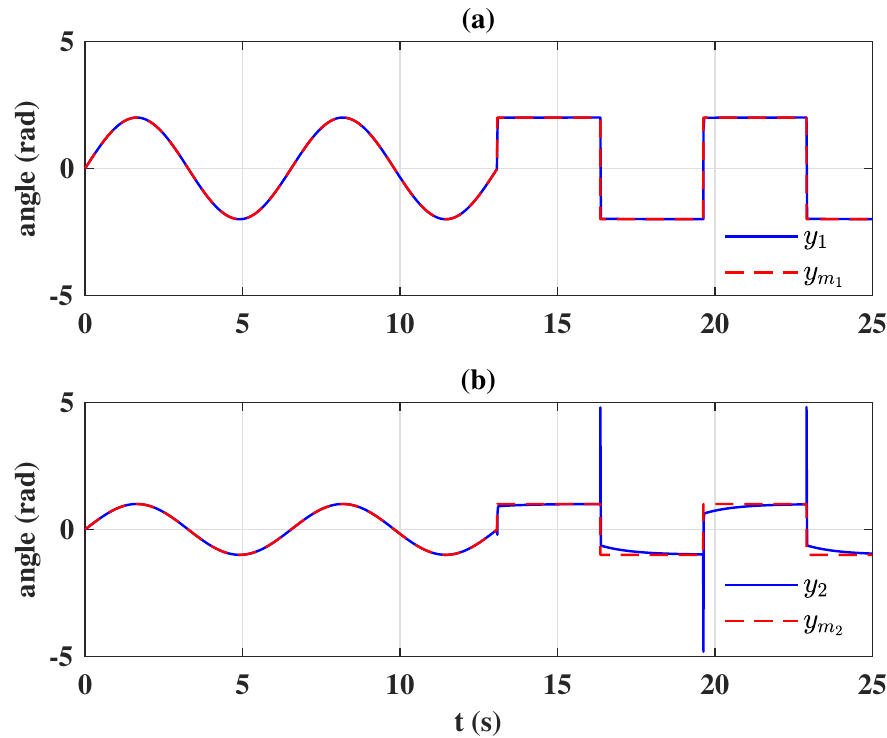
Figure 6. Time history of system outputs and the extended references ( a ) y 1 , y m